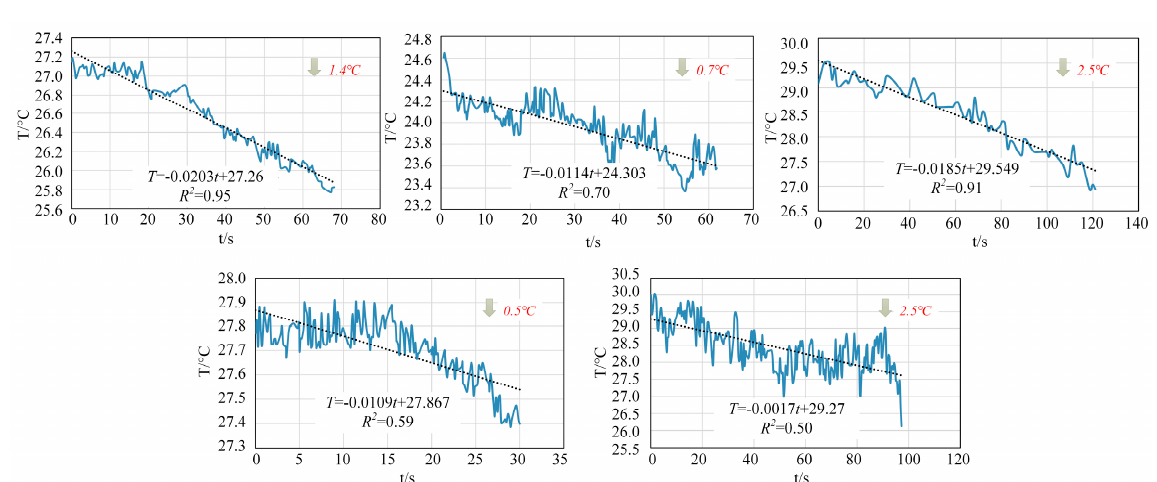
Figure 9. Temperature curve of lining during